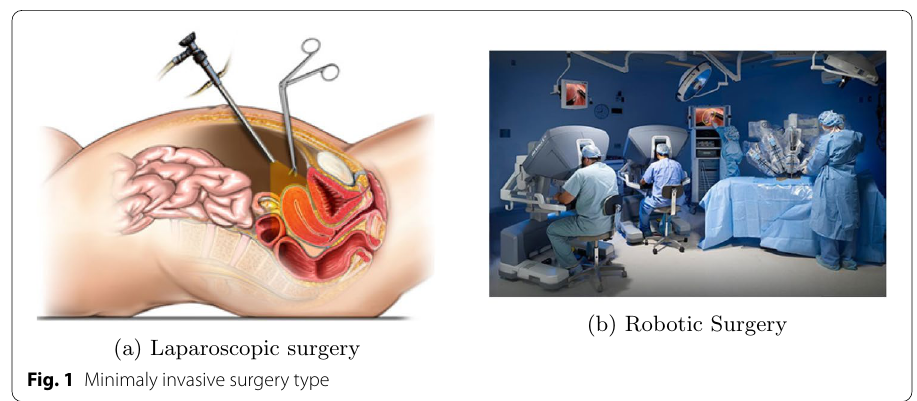
Fig. 1 Minimaly invasive surgery